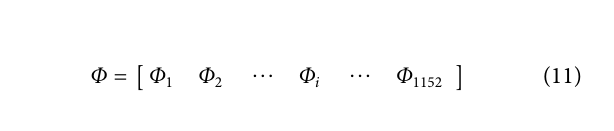
FIGURE 3 | The performance of different protein and drug descriptors on the GPCR